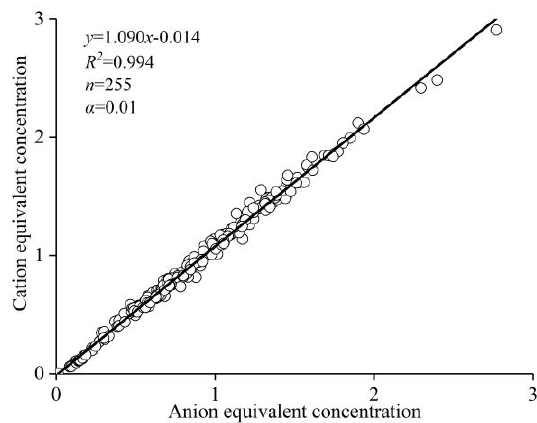
Figure 2. The correlation between anion equivalent concentration and cation equivalent concentration.